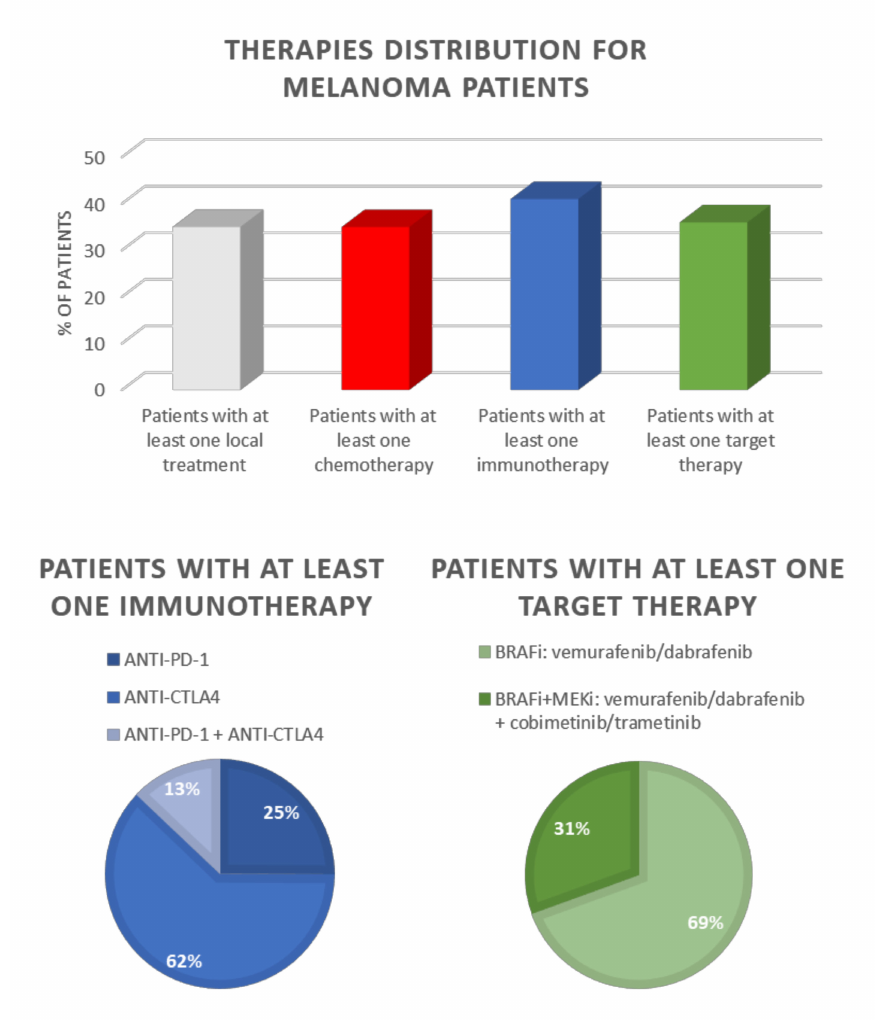
Figure 1. Summary of the most common therapeutic approaches in the Italian clinical landscape for the treatment of advanced metastatic melanoma. Between 30 and 40% of all patients receive at least one immunotherapy or at least one targeted therapy (upper panel). Among the patients treated with immunotherapeutic agents, Anti-CTLA4 (ipilimumab) monotherapy is the most administered (lower panel, left). BRAFi and MEKi combination is the most used targeted therapy (lower panel, right). Data elaborated from